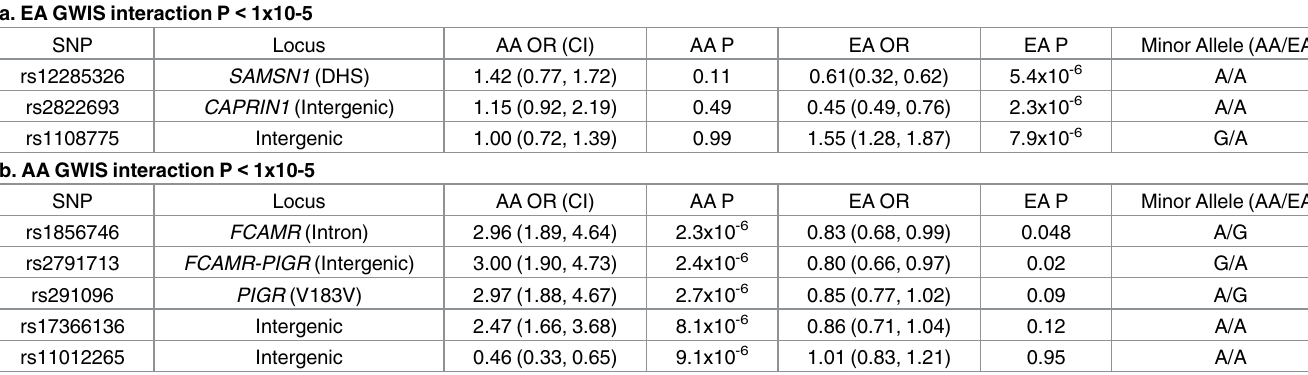
Table 2. GWIS interactions with P < 1x10 -5